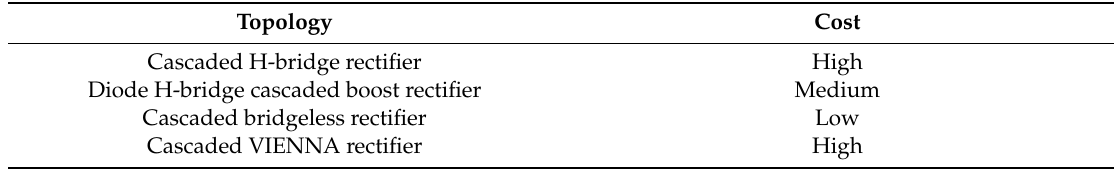
Table 3. Cost comparison of the four